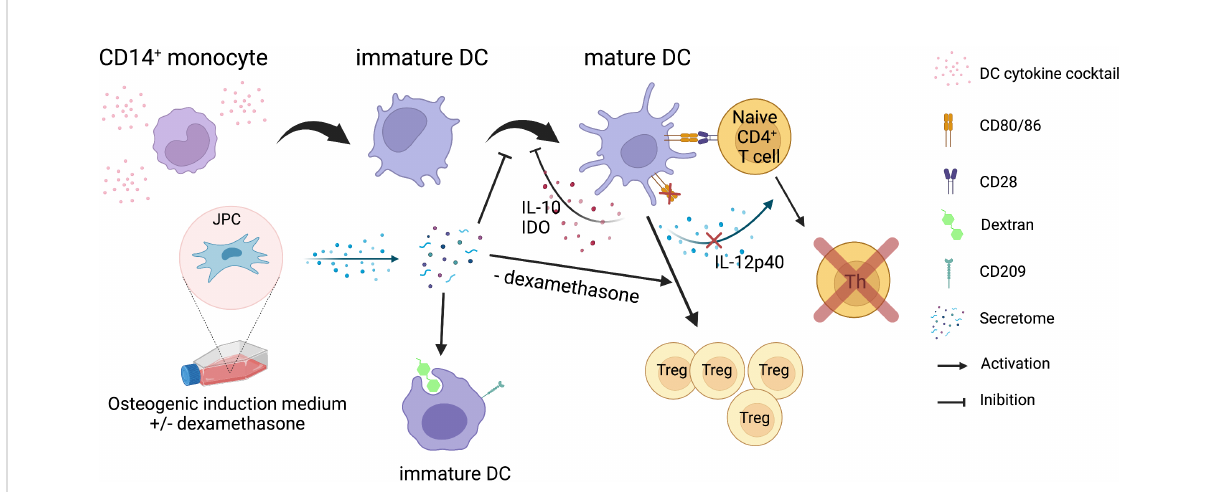
FIGURE 8 Summary of the results obtained in the present study. Illustration of the effects of JPC secretomes derived from osteogenically differentiated cells on MoDC maturation and function. Secretomes from osteogenically induced JPCs inhibit the maturation of CD14 + monocyte-derived DCs and their CD4 + T cell stimulation function, but promote phagocytic function of immature DCs. Secretome from osteogenically induced JPCs in the absence of dexamethasone induced expansion of regulatory T cells. The illustration was created with